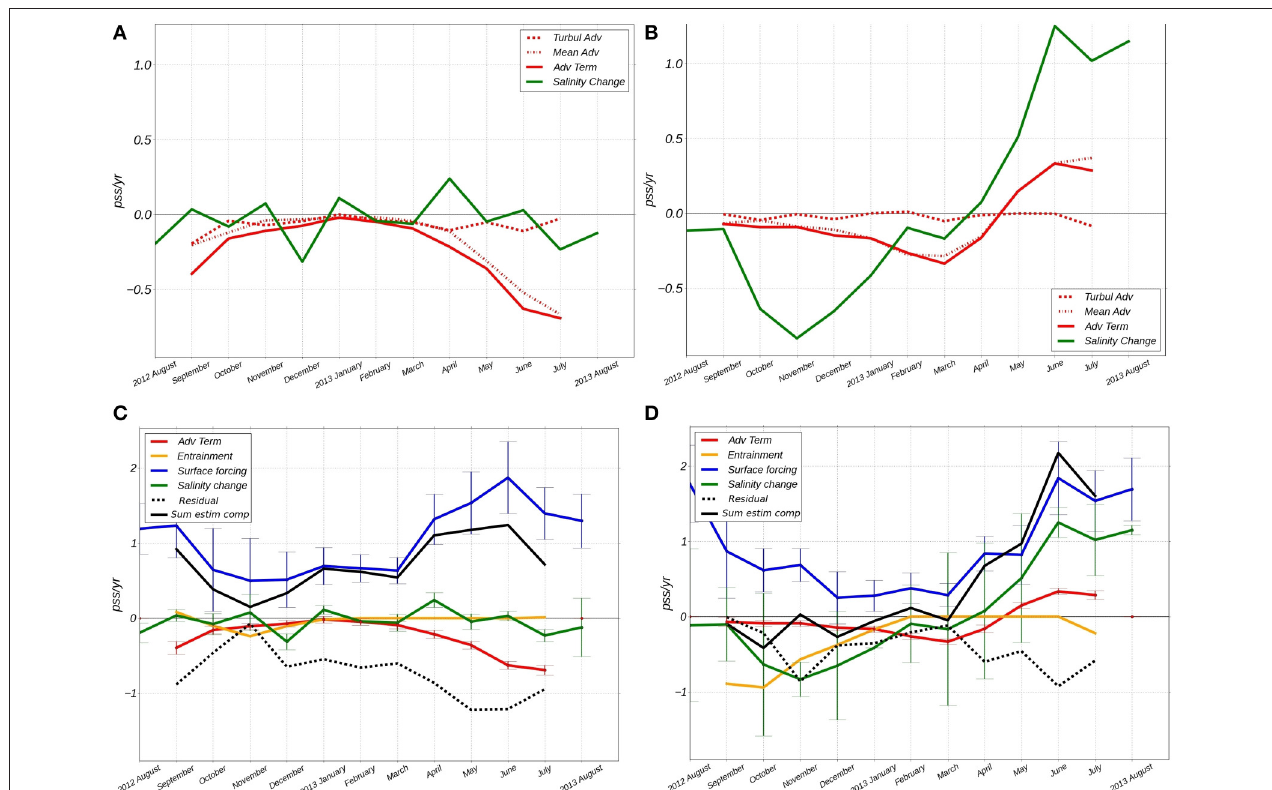
FIGURE 11 | Salinity change (green) and advection components (red) (A,B) and components of salinity budget, residuals (black dashed curves) and sums of right side’s estimated equation components (C,D), Equation (1). (A,C) − 21 ◦ − 25 ◦ N, (B,D) − 25 ◦ − 30 ◦